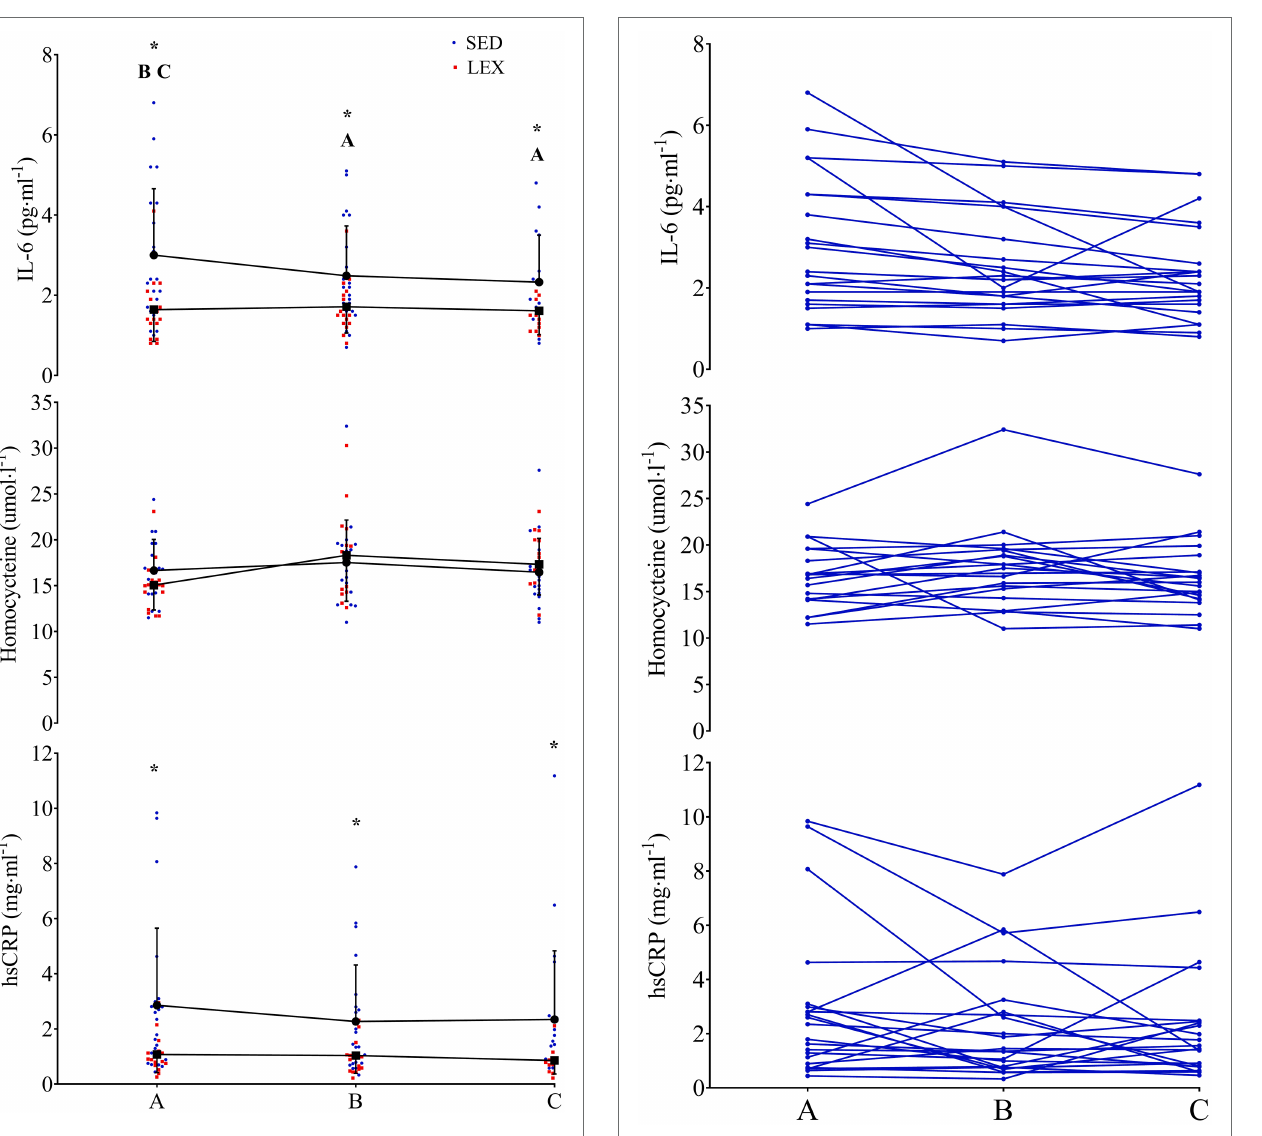
FIGURE 3 | IL-6 (top), homocysteine (middle), and hsCRP (bottom) in previously sedentary older men. Data are presented as individual data points to visualize individual